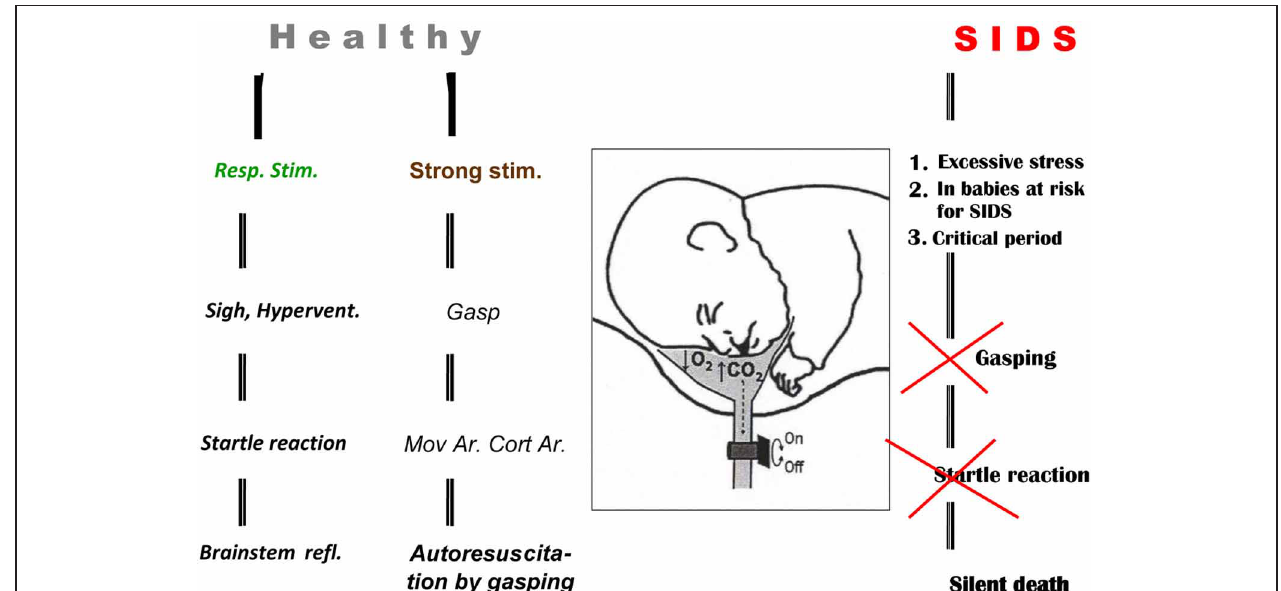
FIGURE 1 | Auto-resuscitation in healthy infant and its failure in SIDS baby. Three different outcomes of respiratory reactions coupled with or without arousal (Ar) in infants are illustrated schematically: (1) normalization of vital functions, mediated by brainstem reflexes connected with sigh and startle reaction, provoked by milder respiratory stimuli without Cortical Arousal—Cort Ar. (2) Auto-resuscitation by